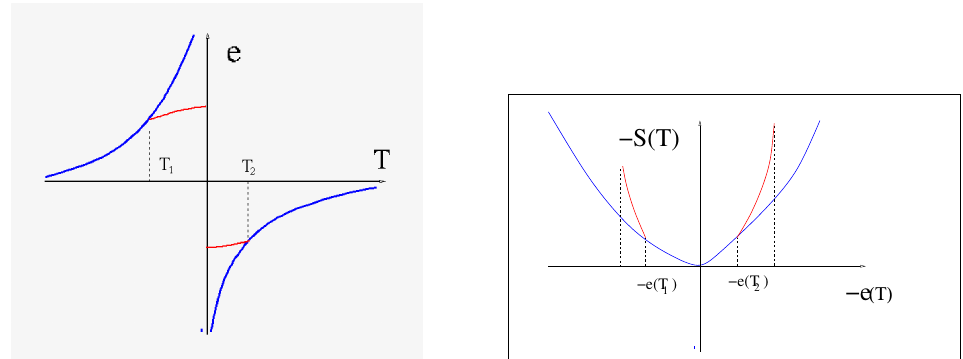
Figure 7: Left: a sketch of an energy versus temperature ( T = β − 1 ) curve for the annealed and quenched problem. Right: the corresponding parametric plot of − s ( T ) = − ∂ T Φ versus − e ( T ) which gives the large deviation function ˜ W ( ˆ A ) for the ∂ T N ˜ W ( ˆ A ) of a diagonal matrix element ˆ A = − e . The range of the probability P ∼ e − 2 quenched probability is bounded, while the one of the annealed problem is